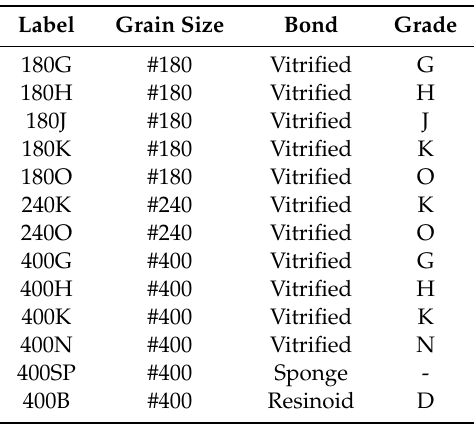
Table 1. Wheels used in the grinding.